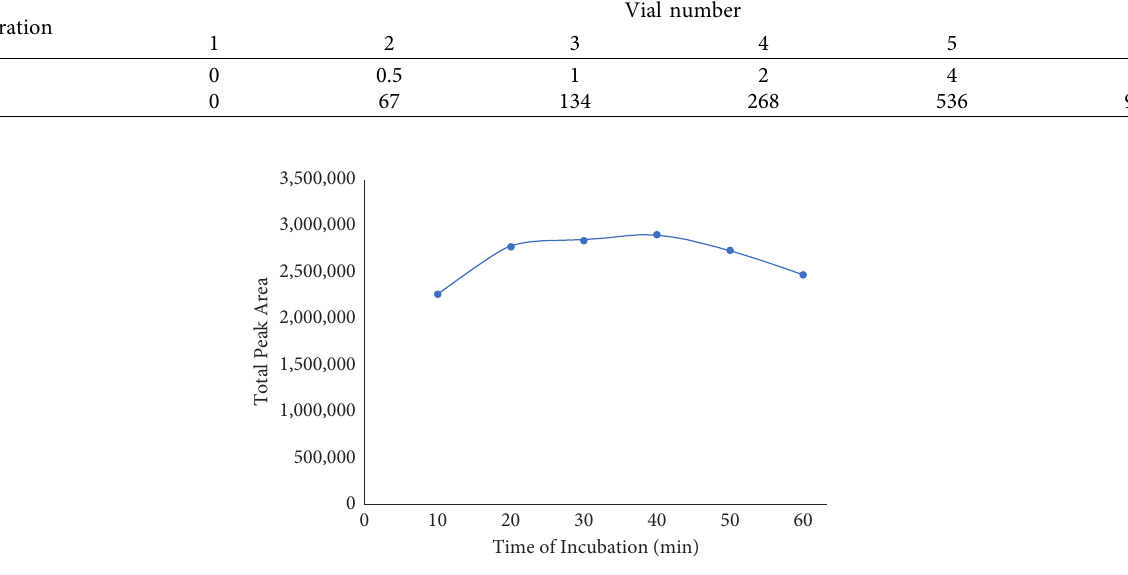
Figure 1: Result of the total peak area of hexane analyzed using different incubation times.